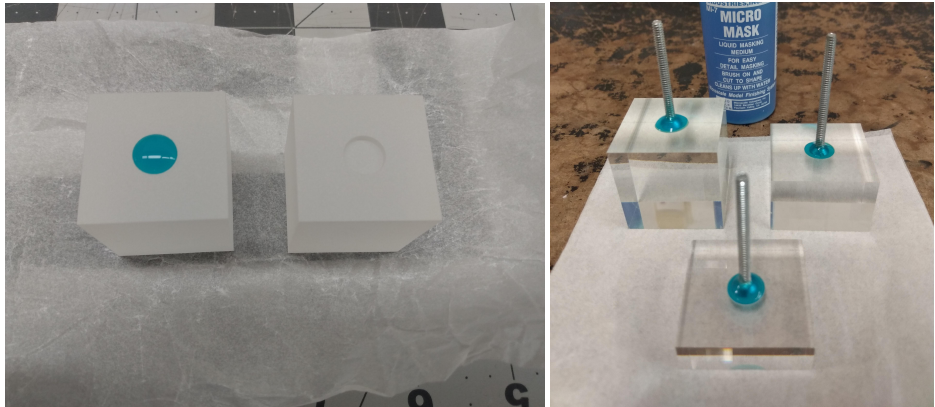
Figure 2. Ground ( left ) and polished ( right ) SF57HHT glass tiles of various